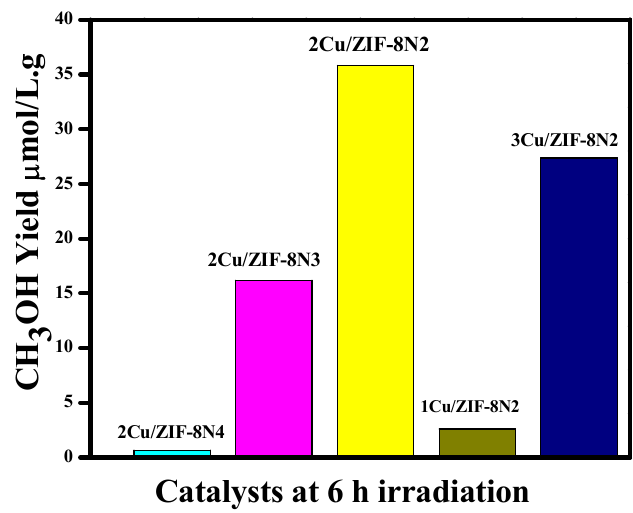
Figure 8. Photocatalytic reduction of CO 2 to CH 3 OH over all Cu/ZIF-8 catalysts at 6 h irradiation.